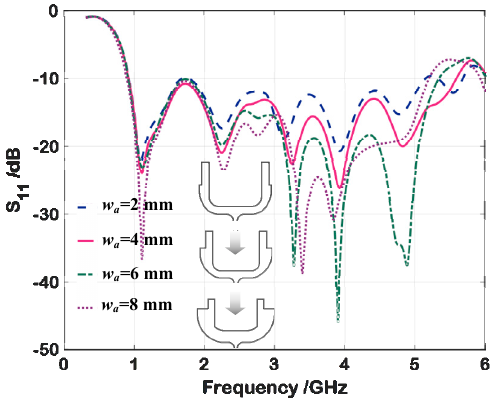
Figure 4. Simulated reflection coefficient of the proposed antenna A with different widths ( w a ) of the added stub.